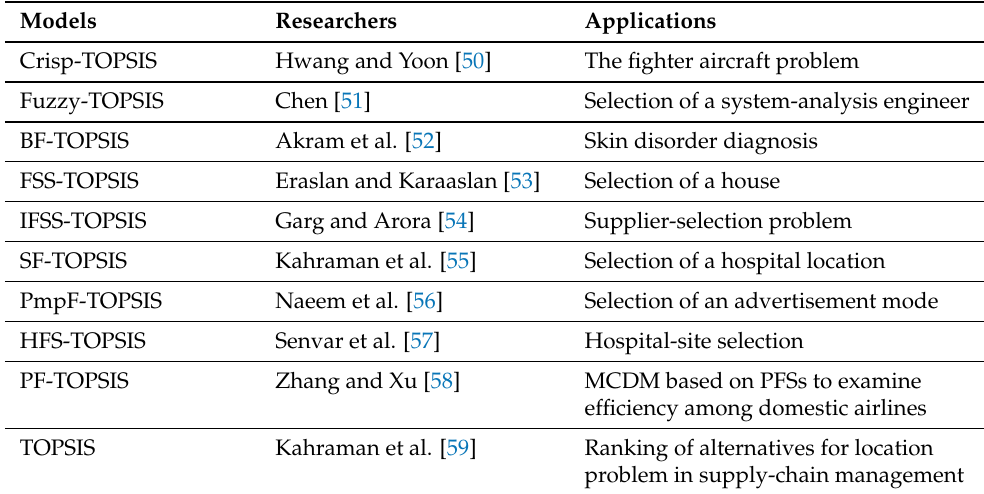
Table 2. Some applications of TOPSIS method based on fuzzy